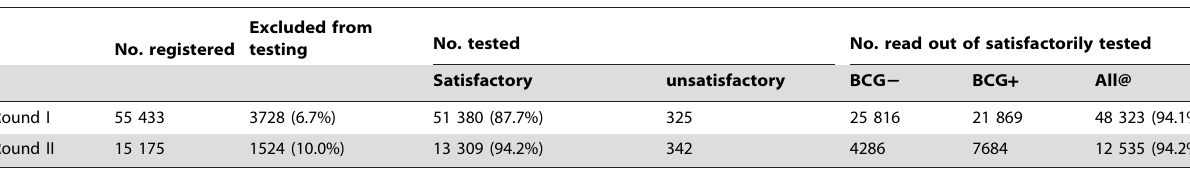
Table 1. Numbers of children investigated, Rounds I and II.